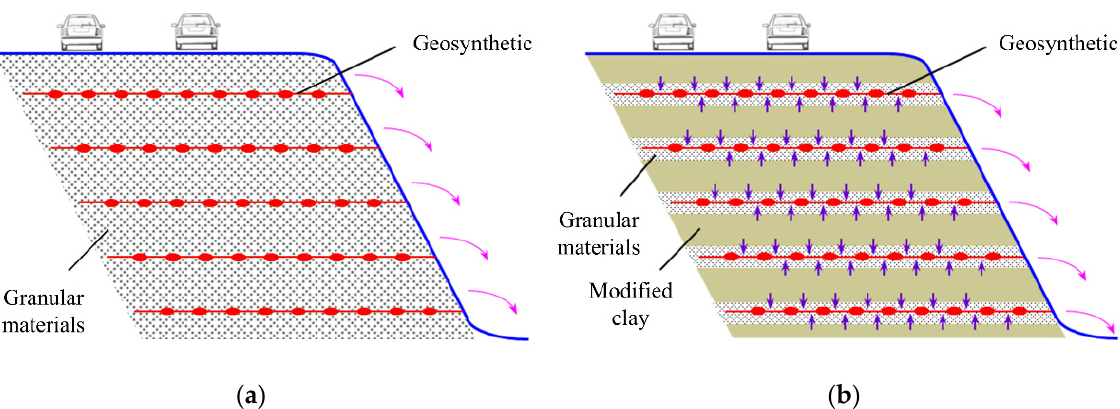
Figure 1. Schematic drawing of the structures: ( a ) commonest geosynthetics-reinforced soil structure; ( b ) layered geosynthetics–granule–clay reinforced structure.